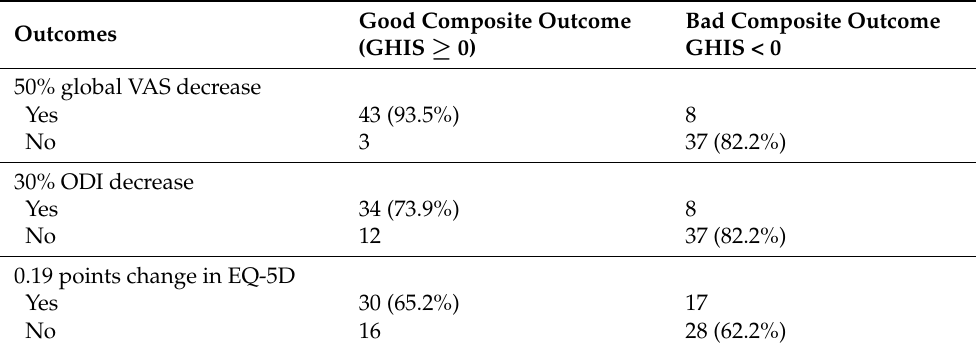
Table 3. Relationship between GHIS outcome and VAS decrease, ODI decrease and improvement in